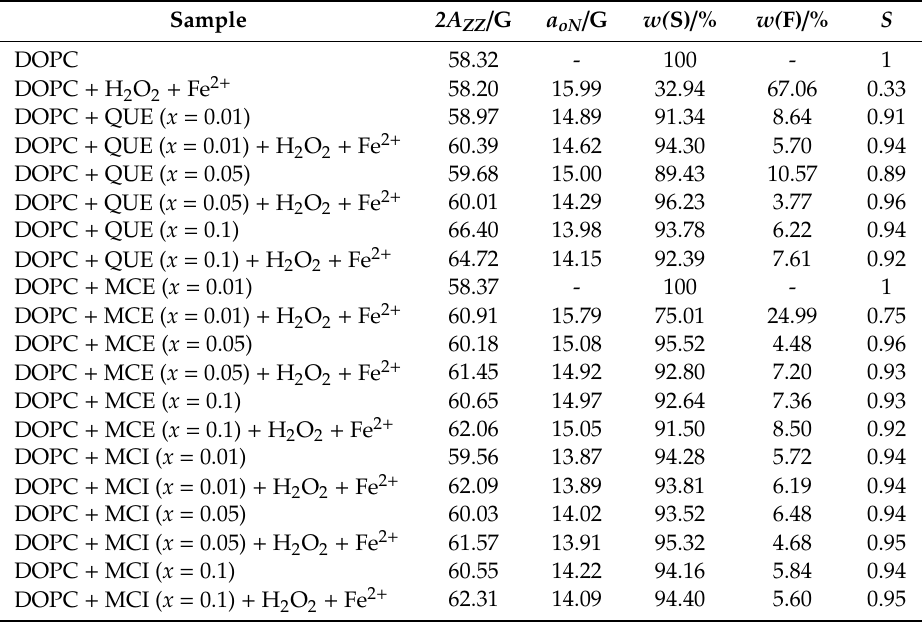
Figure 15. EPR spectra before (a) and after the induced lipid peroxidation (b) of DOPC liposomes with inserted flavonols QUE ( A , x = 0.01; B , x = 0.05; C , x = 0.1), MCE ( D , x = 0.01; E , x = 0.05; F , x = 0.1), and MCI ( G , x = 0.01; H , x = 0.05; I , x = 0.1). Table 3. Spectral parameters for DOPC liposomes with and without inserted flavonols before and after starting the lipid peroxidation process ( T = 291